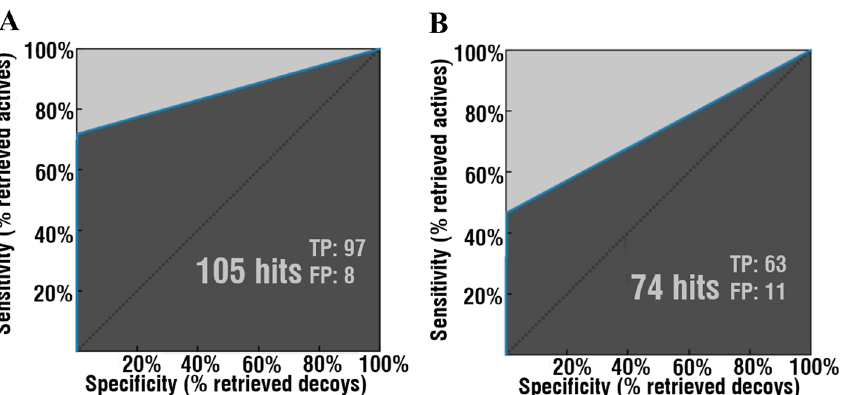
Figure 2. Validation of the generated ligand-based pharmacophore on the two datasets ( A , B ) Identified hit compounds out of 2635 total compounds (135 actives, 2500 decoys). Figure was obtained using LigandScout v4.4 27 (www. intel igand. com/ ligan dscout/). Schematic illustration was drawn using Adobe Illustrator 2018 (www. adobe. com/ produ cts/ illus